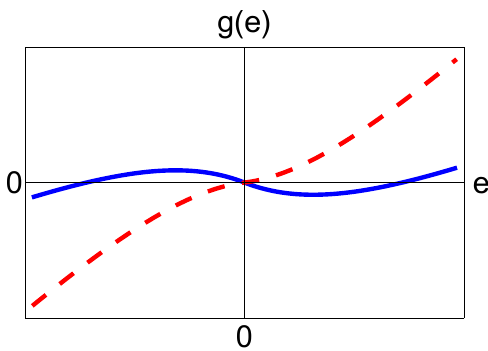
Figure 4 . The two forms of the function g ( e ) = 2 γ 2 e + 3 e ( | e | − curve) and γ 2 ≥ 3 / 2 (red dashed